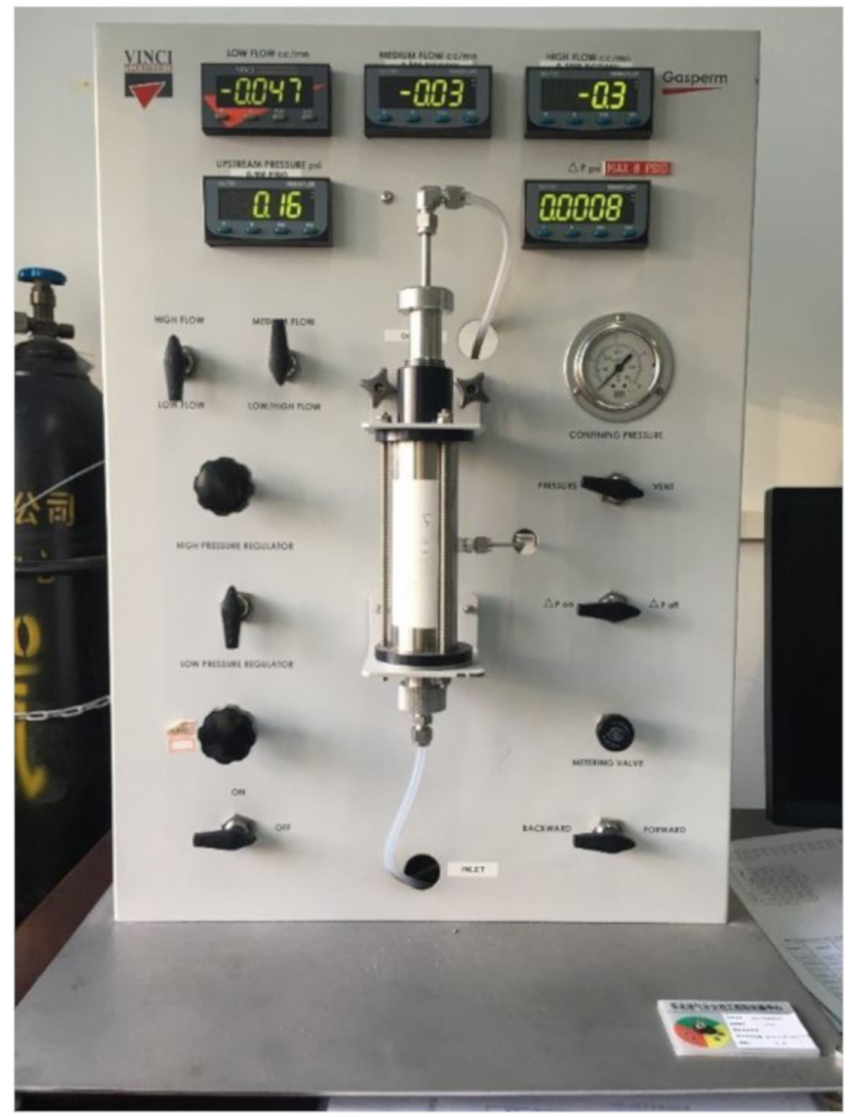
Figure 6. Gasperm